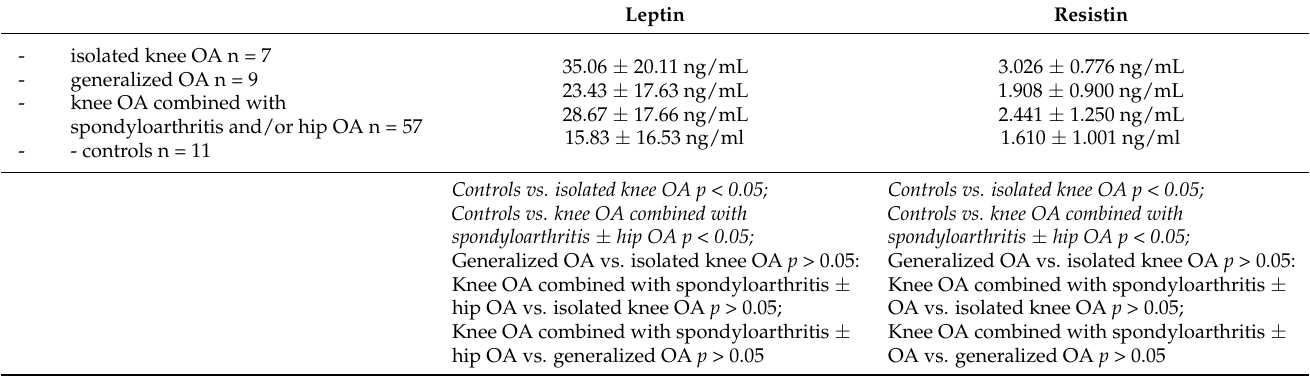
Table 2. Leptin and resistin level in the presence of OA with different localization.